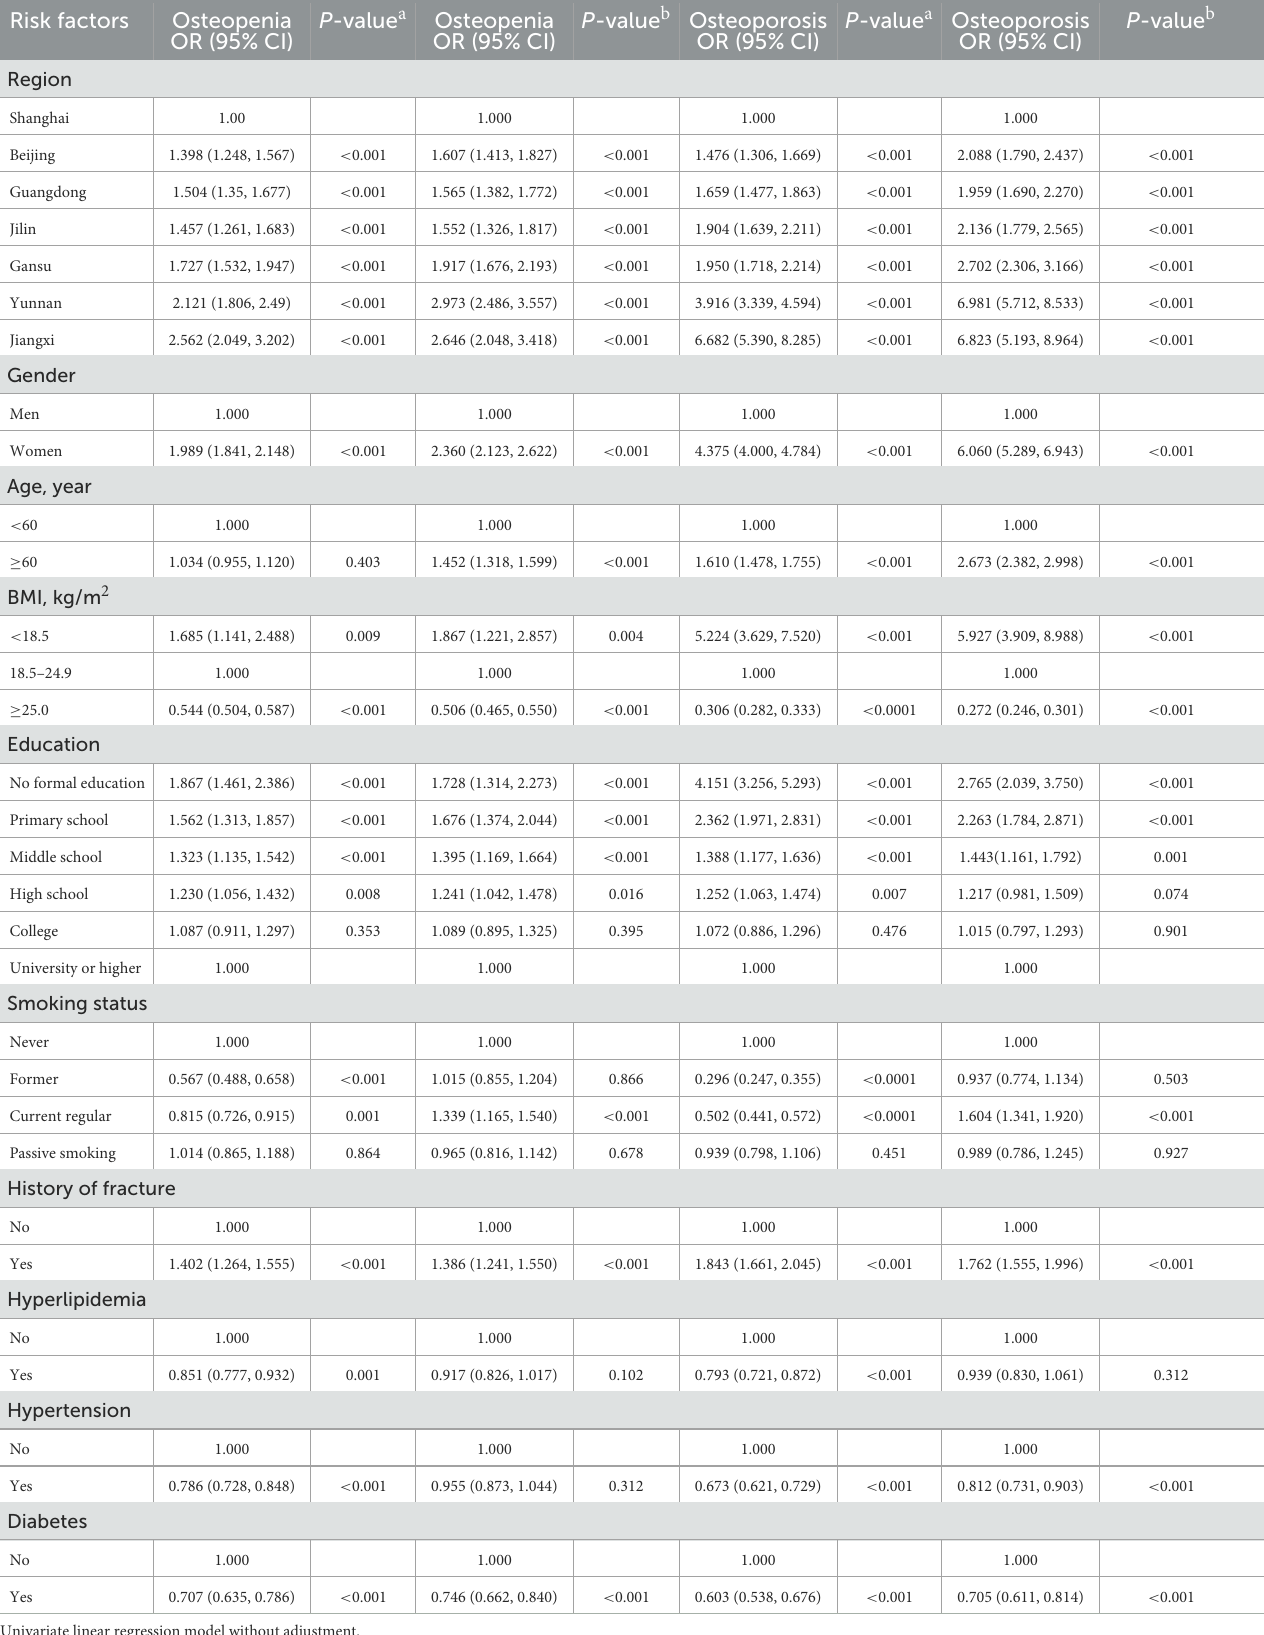
TABLE 3 Risk factors for osteoporosis and osteopenia by univariate and multivariate logistic regression analyses. Risk